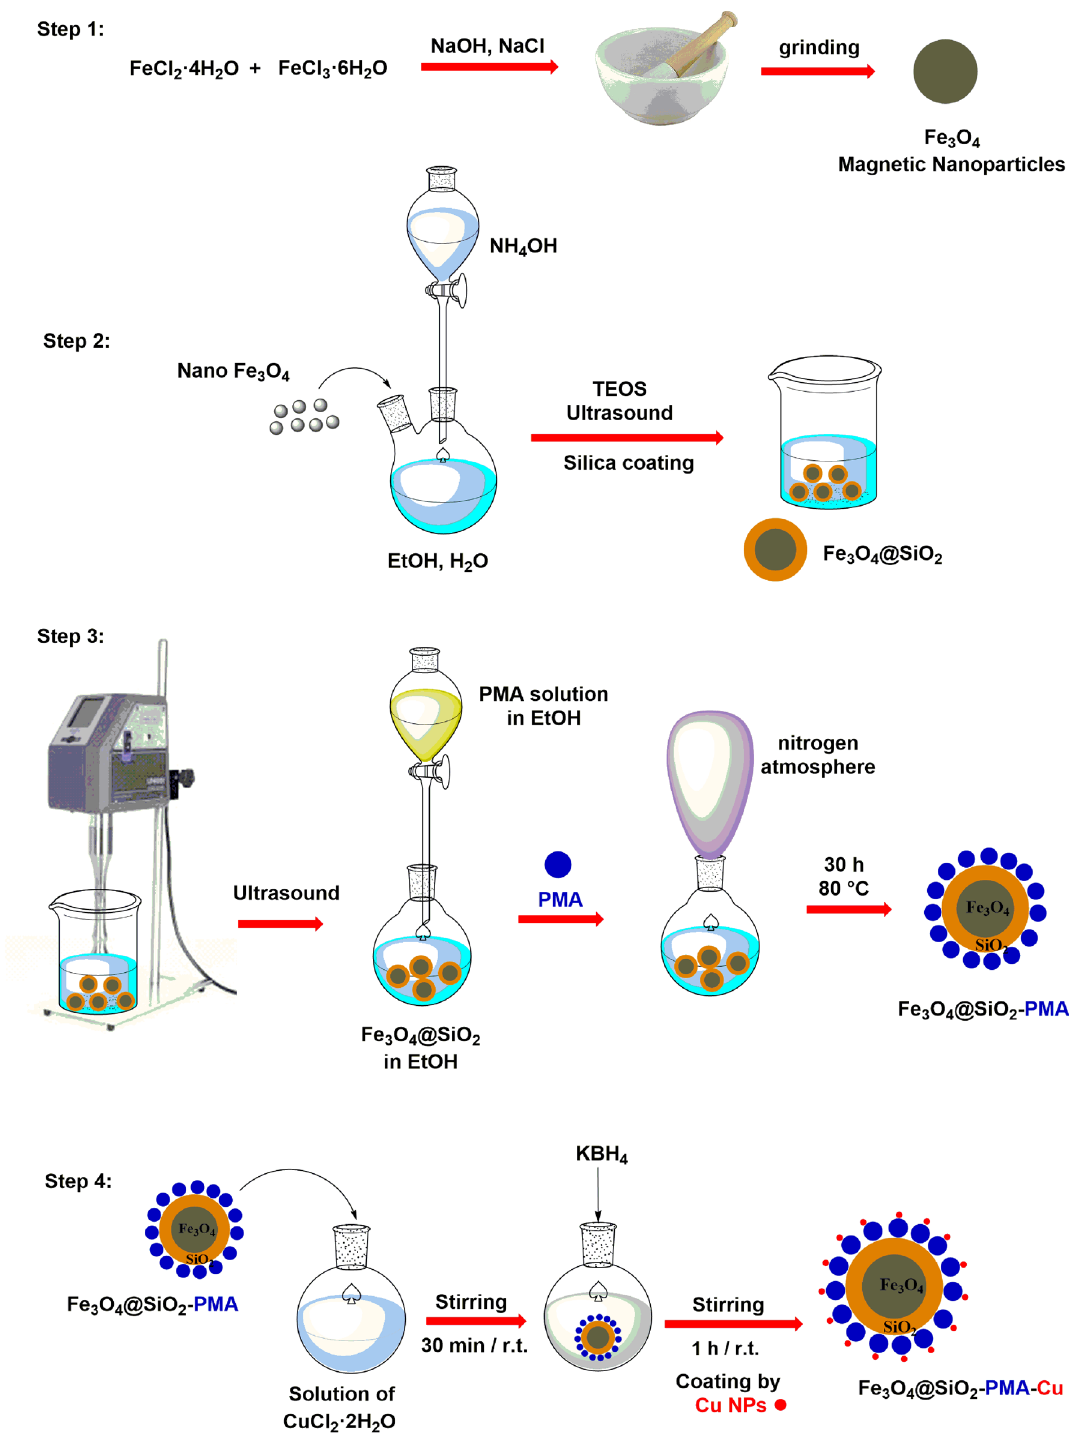
Figure 2. Four-step synthesis of Fe 3 O 4 @SiO 2